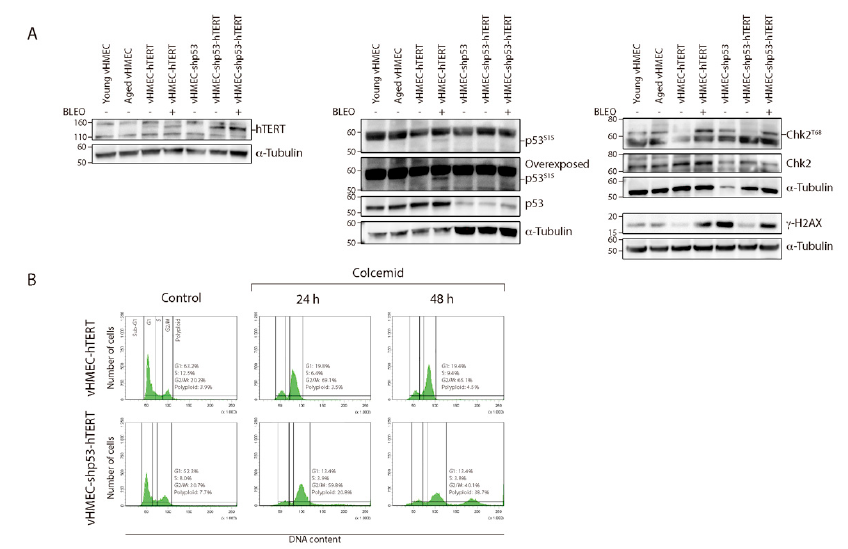
Figure 2. Validation of hTERT immortalisation and p53 downregulation in the different vHMECs. ( A ) Immunoblots of untreated cell lines as well as Bleocin™-treated p53-proficient and deficient immortalised vHMECs. Expression of the catalytic subunit of telomerase (hTERT) was observed at approximately 120 kDa only in the immortalised cell lines. Please note that at 160 kDa there is an unspecific band. A higher expression of hTERT, i.e., stronger band, was observed in the p53-deficient derivatives. α -Tubulin was used as loading control. The same protein extracts were immunoblotted for p53. Diminished levels of p53 were observed in the shp53-vHMEC variants after α -Tubulin normalisation. In addition, the functionality of p53 was validated by checking for the presence of p53 S15 after DSBs induction by Bleocin™. Only p53-proficient immortalised vHMECs showed enhanced p53 S15 levels after DNA damage. α -Tubulin was used as loading control. The presence of DNA damage was determined in the different cell lines by blotting γ -H2AX, a marker of DSBs. After α -Tubulin normalisation, the γ -H2AX levels were observed to increase in finite vHMECs concomitant to increasing telomere shortening and specifically when p53 function was abrogated. hTERT immortalisation reduced γ -H2AX levels in both p53-proficient and deficient vHMECs, but in vHMEC-shp53-hTERT DSBs still remained, as the level of γ -H2AX was comparable to that of telomere-compromised vHMECs. Similarly, Chk2 T68 , another marker of DSBs, was noticed in the finite and the Bleocin™-treated immortalised cells; ( B ) Representative cell cycle profiles of vHMEC-hTERT and vHMEC-shp53-hTERT cell lines 24 h and 48 h after colcemid treatment, as well as their respective controls. Cell cycle profiles remained stable throughout the time of the experiment for untreated cells. Colcemid treatment produced an accumulation of cells in the G2/M phase in vHMEC-hTERT. In the p53 compromised cells there was, in addition to the G2/M increase, an accumulation of cycling polyploids, i.e., more than 4N DNA content, specifically at 48 h after treatment. Cell cycle phases are marked and values indicated. A minimum of 10,000 cells were analysed per experiment.